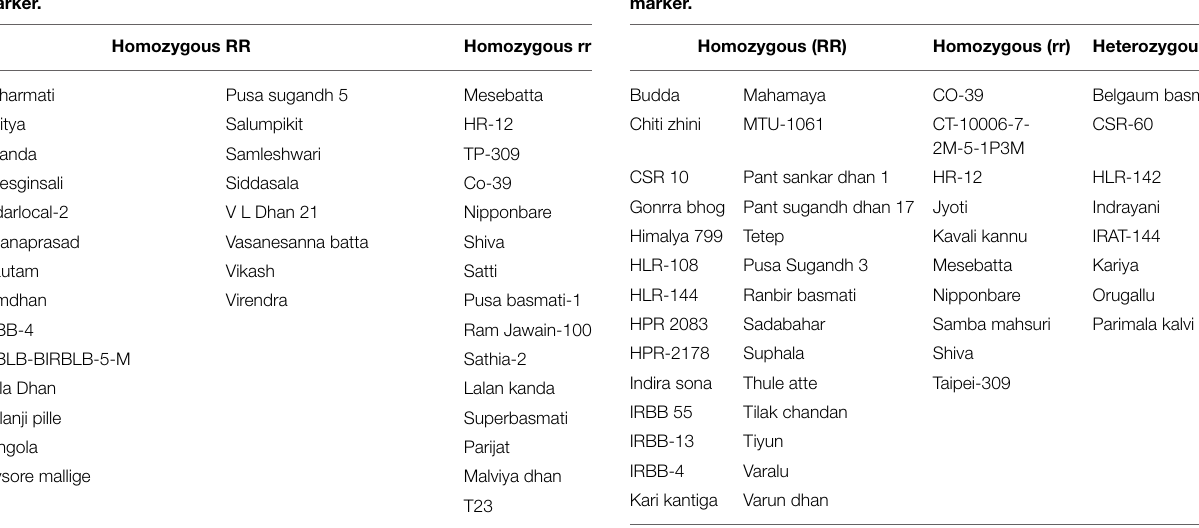
marker (C144_F and C144_R) in 26 rice lines. bp- base pair; M- 100 bp molecular marker. Lanes 1–10: presence of susceptible band (CO-39, HR-12, CT-10006-7-2M-5-1P3M, Jyoti, Kavali kannu, Mesebatta, Nipponbare, Samba mahsuri, Shiva, Taipei-309); lanes 11–18: presence of resistant band (Tetep, Budda, Chiti zhini, CSR 10, Gonrra bhog, Himalya 799, Pusa Sugandh 3, Ranbir basmati, Sadabahar); lanes 19–25: presence of both the bands (Belgaum basmati, CSR-60, HLR-142, Indrayani, IRAT-144, Kariya).